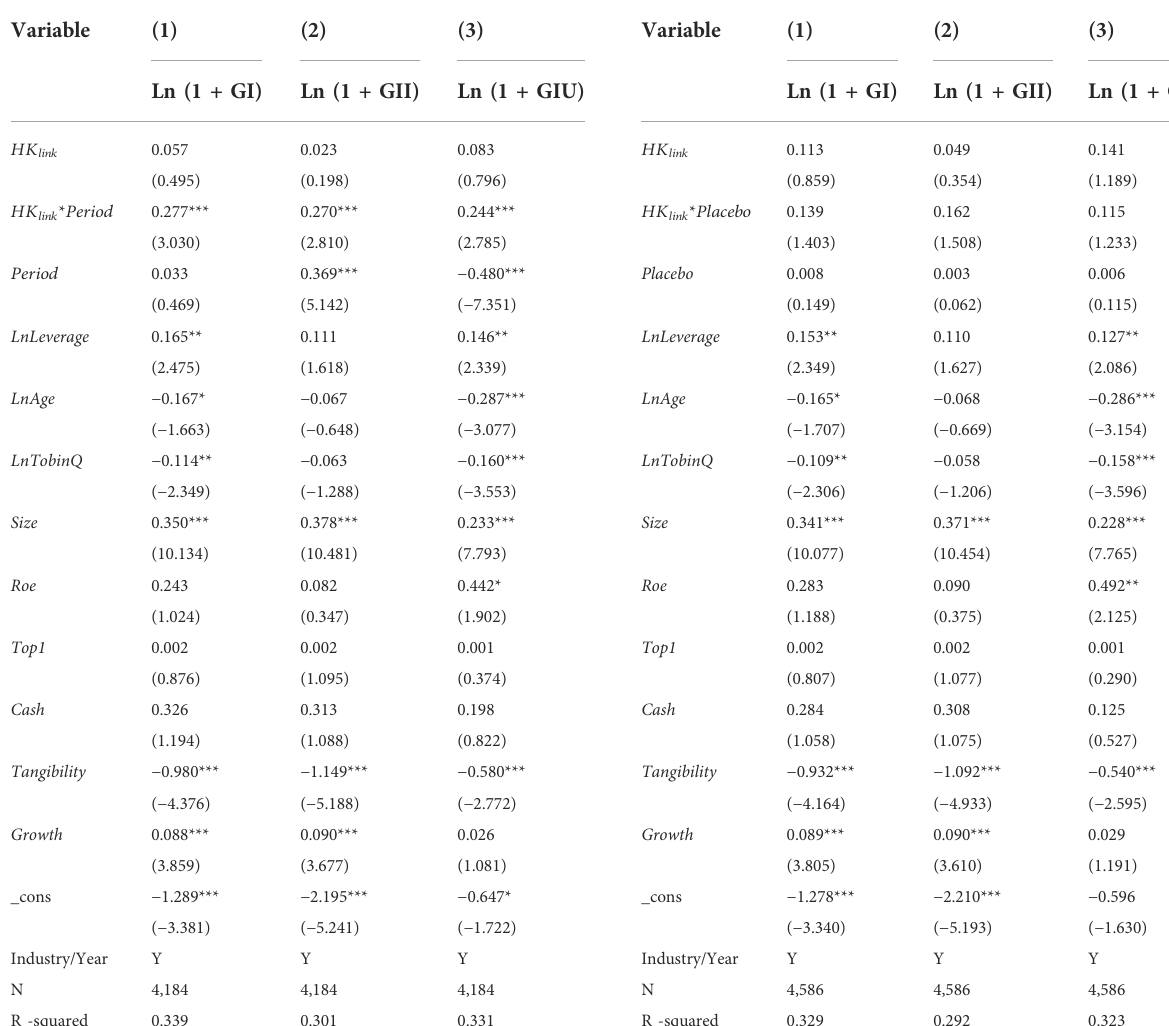
TABLE 6 Robustness test: Standard DID model. TABLE 7 Robustness test: Placebo